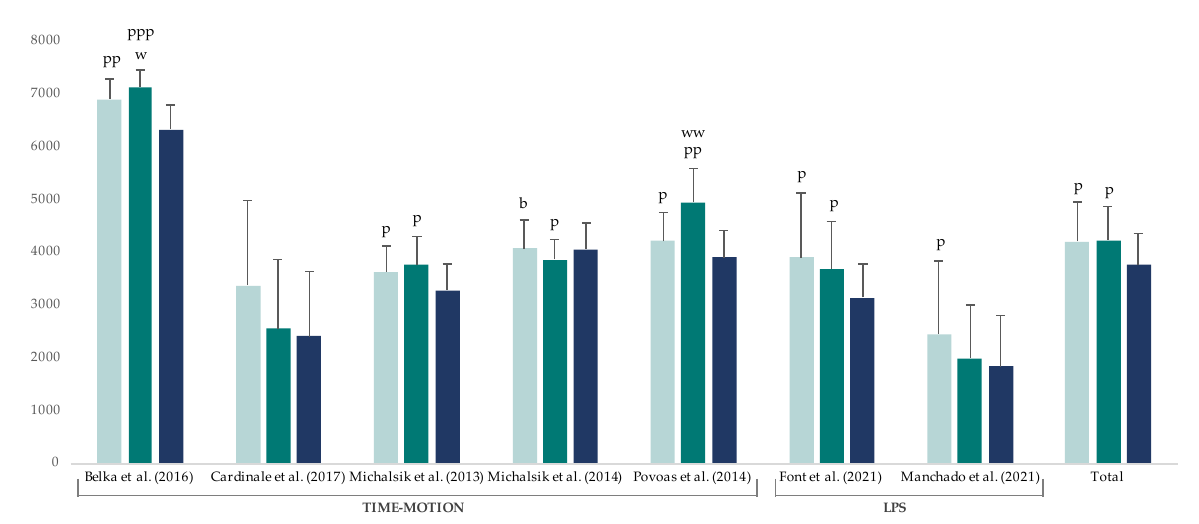
Figure 3. Total distance covered according to playing positions. The magnitude of the standardised differences (effect size) between the different positions is indicated by the number of symbols: one symbol stands for a moderate difference, two for a large difference and three for a very large difference. b stands for substantial difference vs. backs, w vs. wings and p vs. pivot [10,12,15,40,42,43,48].